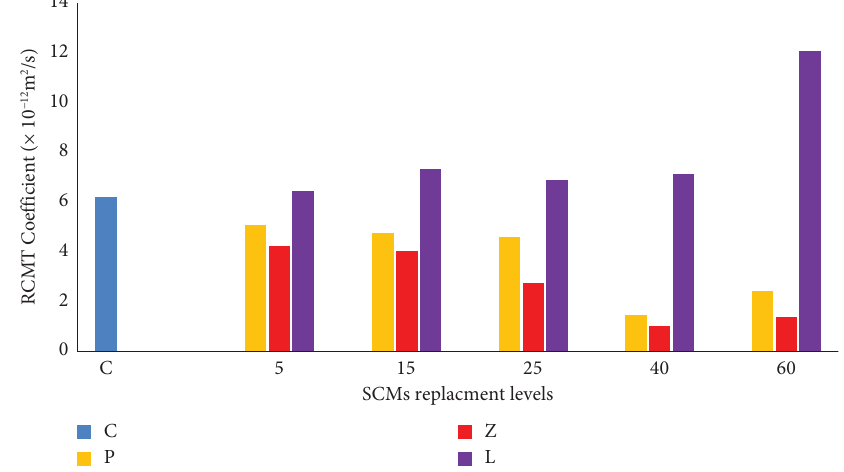
Figure 10: Rapid chloride migration test coefcient of the mixtures at the age of